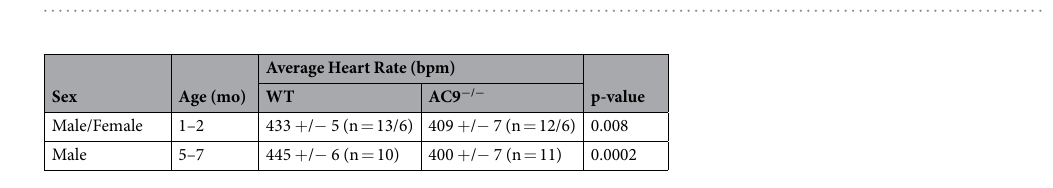
Figure 2. AC9 activity and AKAP association in heart. (A , B ) Membranes were prepared from 6 wk WT versus AC9 − / − heart. ( A ) AC activity was measured under basal conditions and upon stimulation with 300 nM G α s or 50 µ M forskolin (n = 4, performed in duplicate or triplicate). ( B ) AC activity was measured in the presence of increasing concentrations of SQ22,536 in the presence of 300 nM G α s (n = 3, performed in duplicate). ( C , D ) Heart extracts from WT or AC9 − / − mice were subjected to immunoprecipitation (IP) with pre-immune (control) or anti-Yotiao (C) and control IgG or anti-AKAP5 (D) . AKAP-associated AC activity was stimulated with 300 nM G α s and measured (n = 3–4). Data are shown as mean + / − SD. A portion of the IP’s from ( C and D ) were subjected to WB analysis for the appropriate AKAP. ( E ) Yotiao-associated AC activity was measured from WT sinoatrial node (SAN), left ventricle (LV), and right atrium (RA) tissue homogenates as in panel (C). Immunoblot of Yotiao from IPs is shown below. ( F ) Yotiao-associated activity from WT and AC9 − / − SAN as measured in panel (C); Yotiao immunoblot is shown below (n = 3). Full-length WBs are presented in Supplementary Fig. S6.